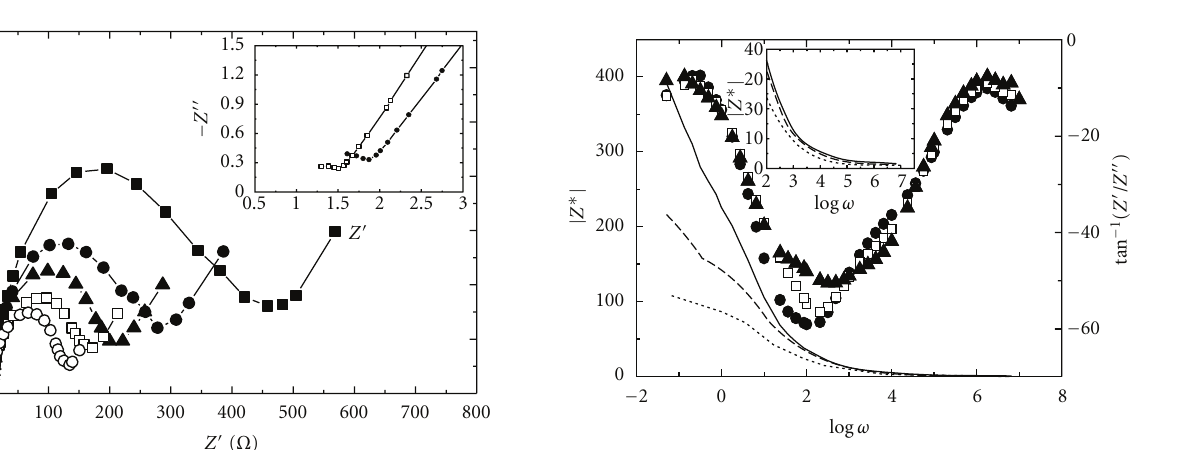
Figure 9: Bode diagram showing the variation of the modulus of the impedance | Z ∗ | (lines) and the out-of-phase angle ( φ = tan − 1 / ( Z (cid:8)(cid:8) /Z (cid:8) ) (symbols) with the frequency at 20 ◦ C (solid line and filled circles), 40 ◦ C (dash line and open squares) and 60 ◦ C (dot line and filled triangles) for the P5FNDIHS membrane in the acid form equilibrated with distilled water.